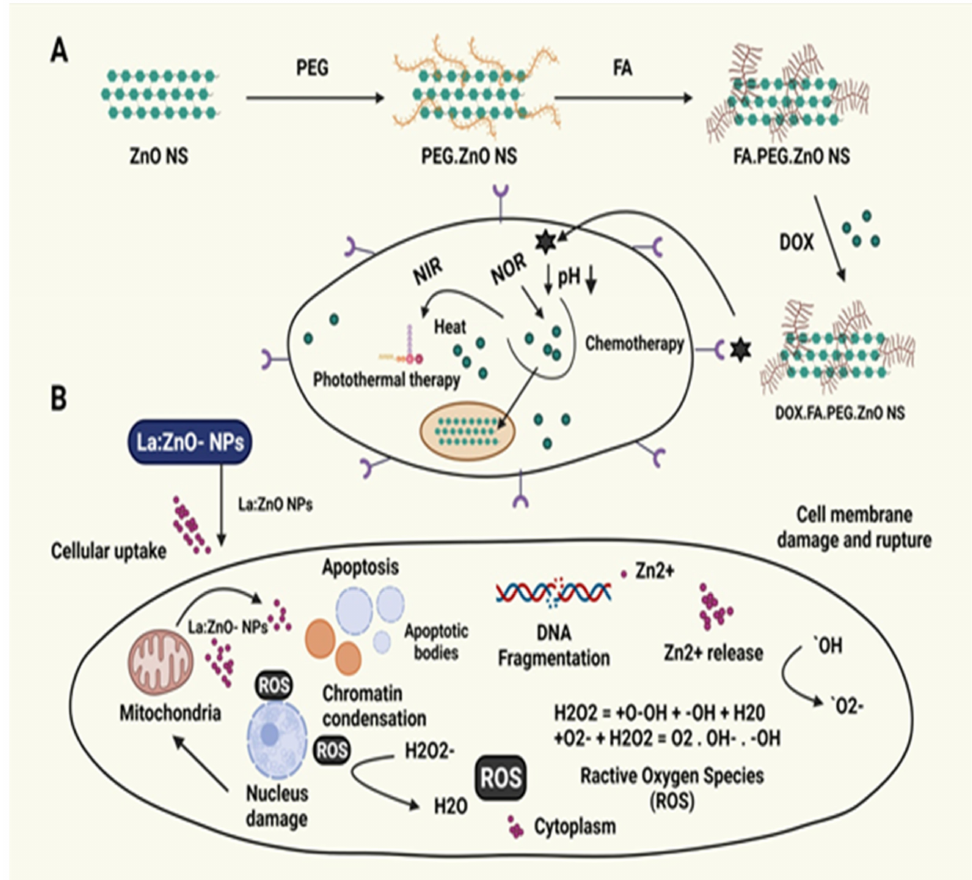
Figure 10. The mechanisms underlying the anticancer activity of green ZnO-NPs. ( A ) Cytotoxic action of La-doped ZnO-NPs causes cell death [195]. ( B ) The development of DOX-FA-ZnO NS is a unique breast cancer treatment drug delivery system [195]. ZnO nanostructures (ZnO-NS), doxorubicin (DOX), folic acid (FA), near-infrared (NIR), polyethylene glycol (PEG), and lanthanum (La) are all components of